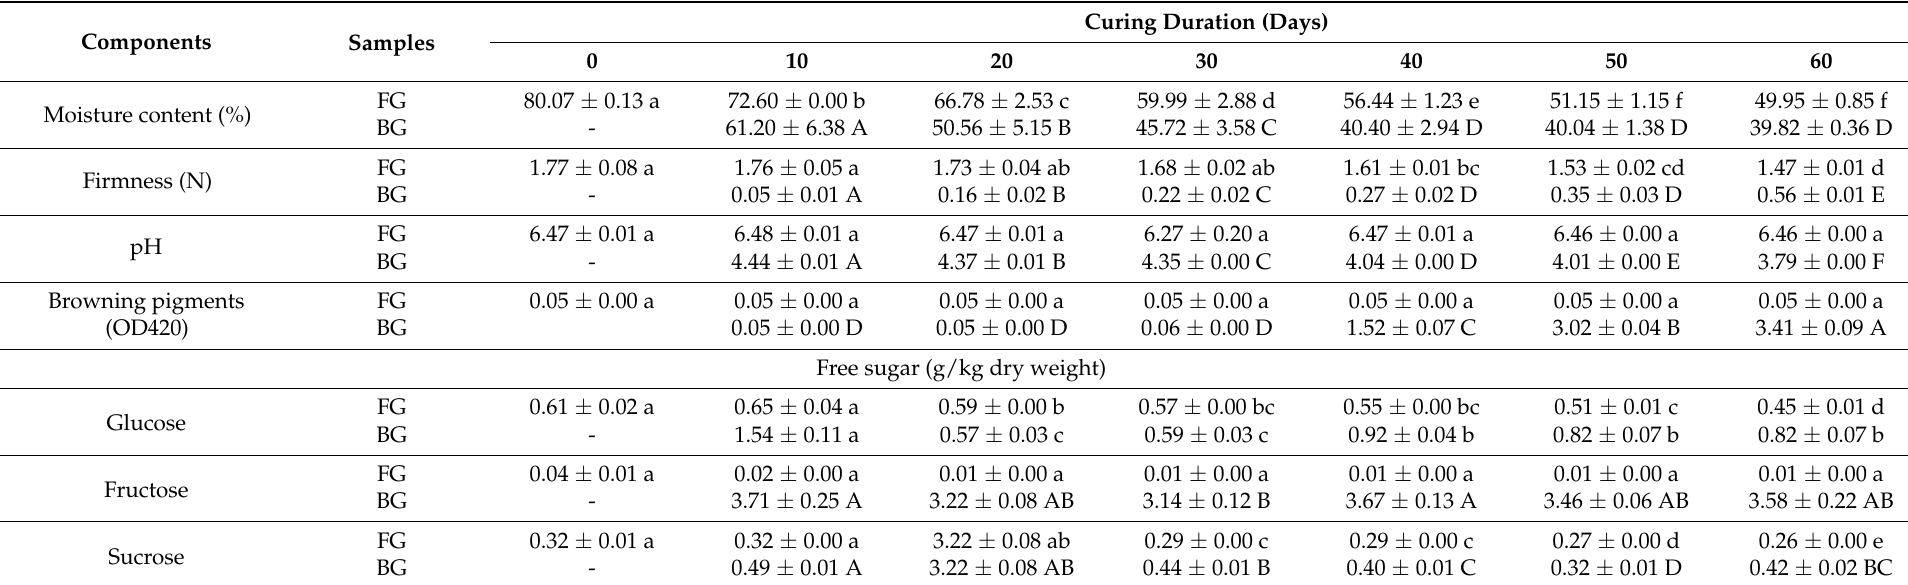
Table 1. Physiochemical properties of fresh garlic and black garlic with different curing